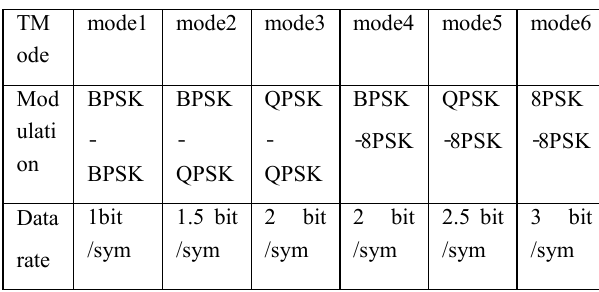
the received SNR } for different transmission modes, according to the